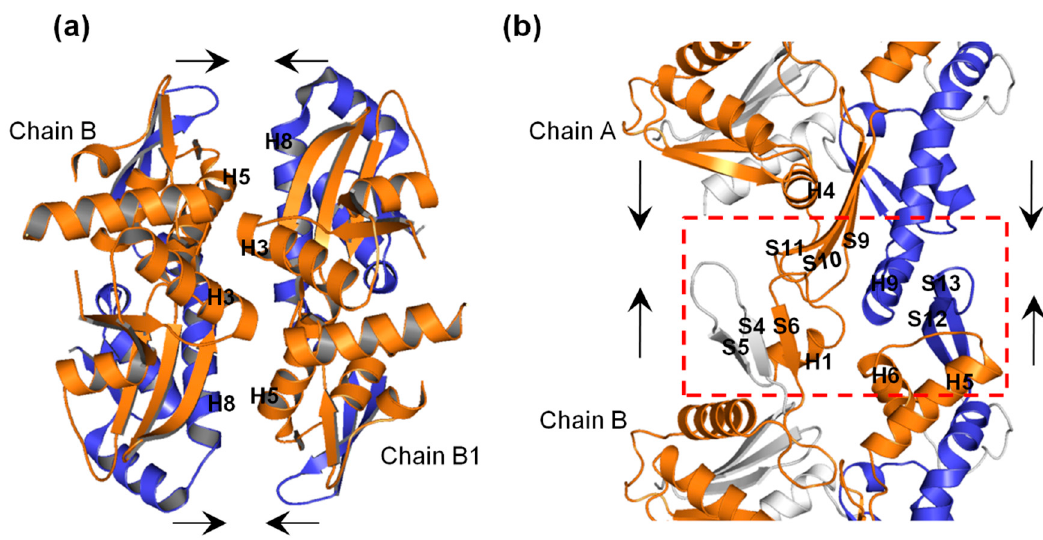
Figure 8. Interactions of Ile55-Ile219 (orange) and Ser232-Val316 (blue) segments in MreB double and single protofilaments. ( a ) Interactions in double protofilament (filament dimerization). ( b ) Interactions in single protofilament. The red dashed-rectangle shows the intraprotofilament interface between chains A and B, and the secondary structural elements that could establish contacts. The arrows signify the interactions.